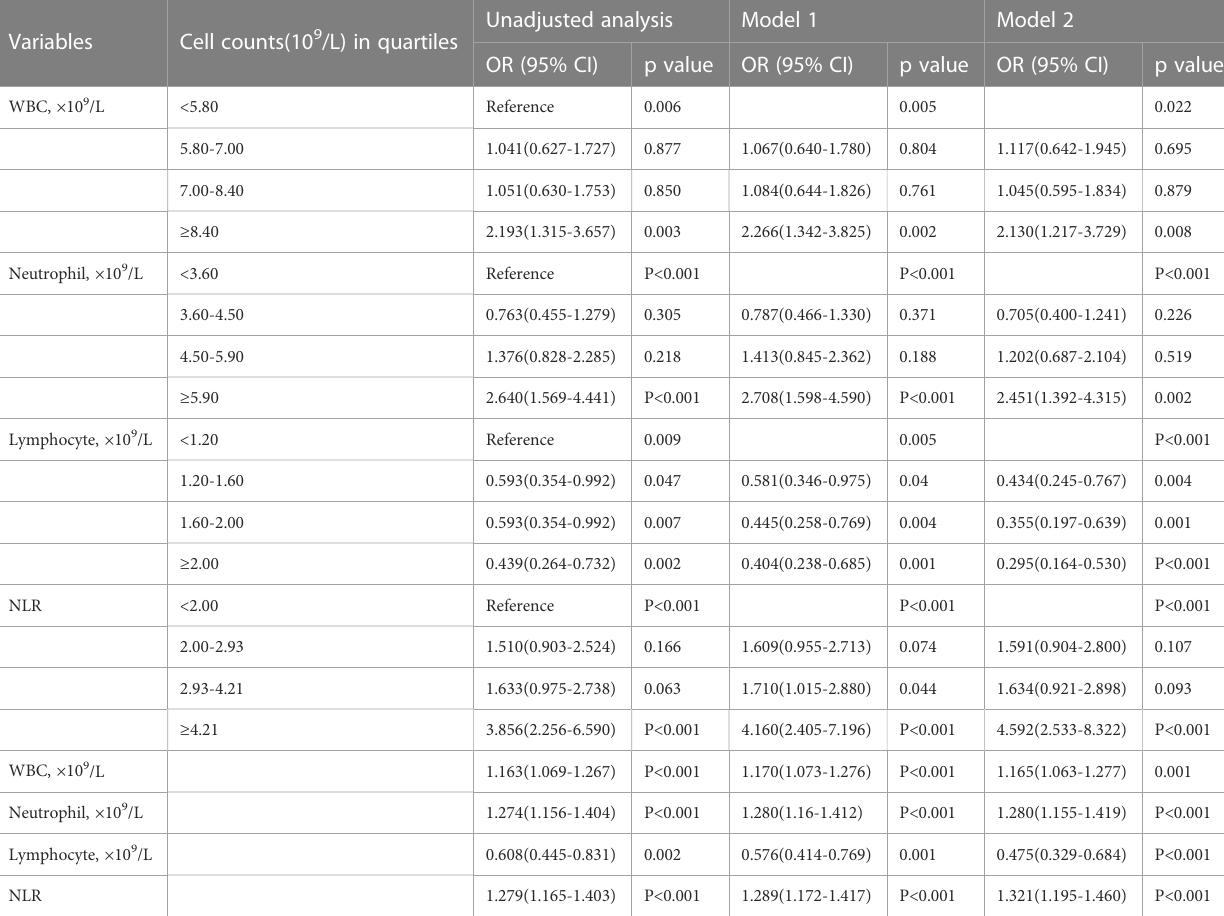
TABLE 2 Unadjusted and adjusted analyses of WBC, neutrophil counts, lymphocyte counts, and NLR with high SHR group.